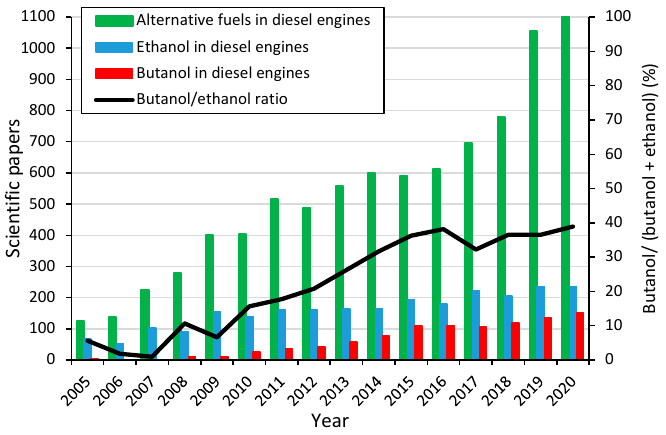
Figure 1. Bibliometric diagram. ISI web of knowledge [27].